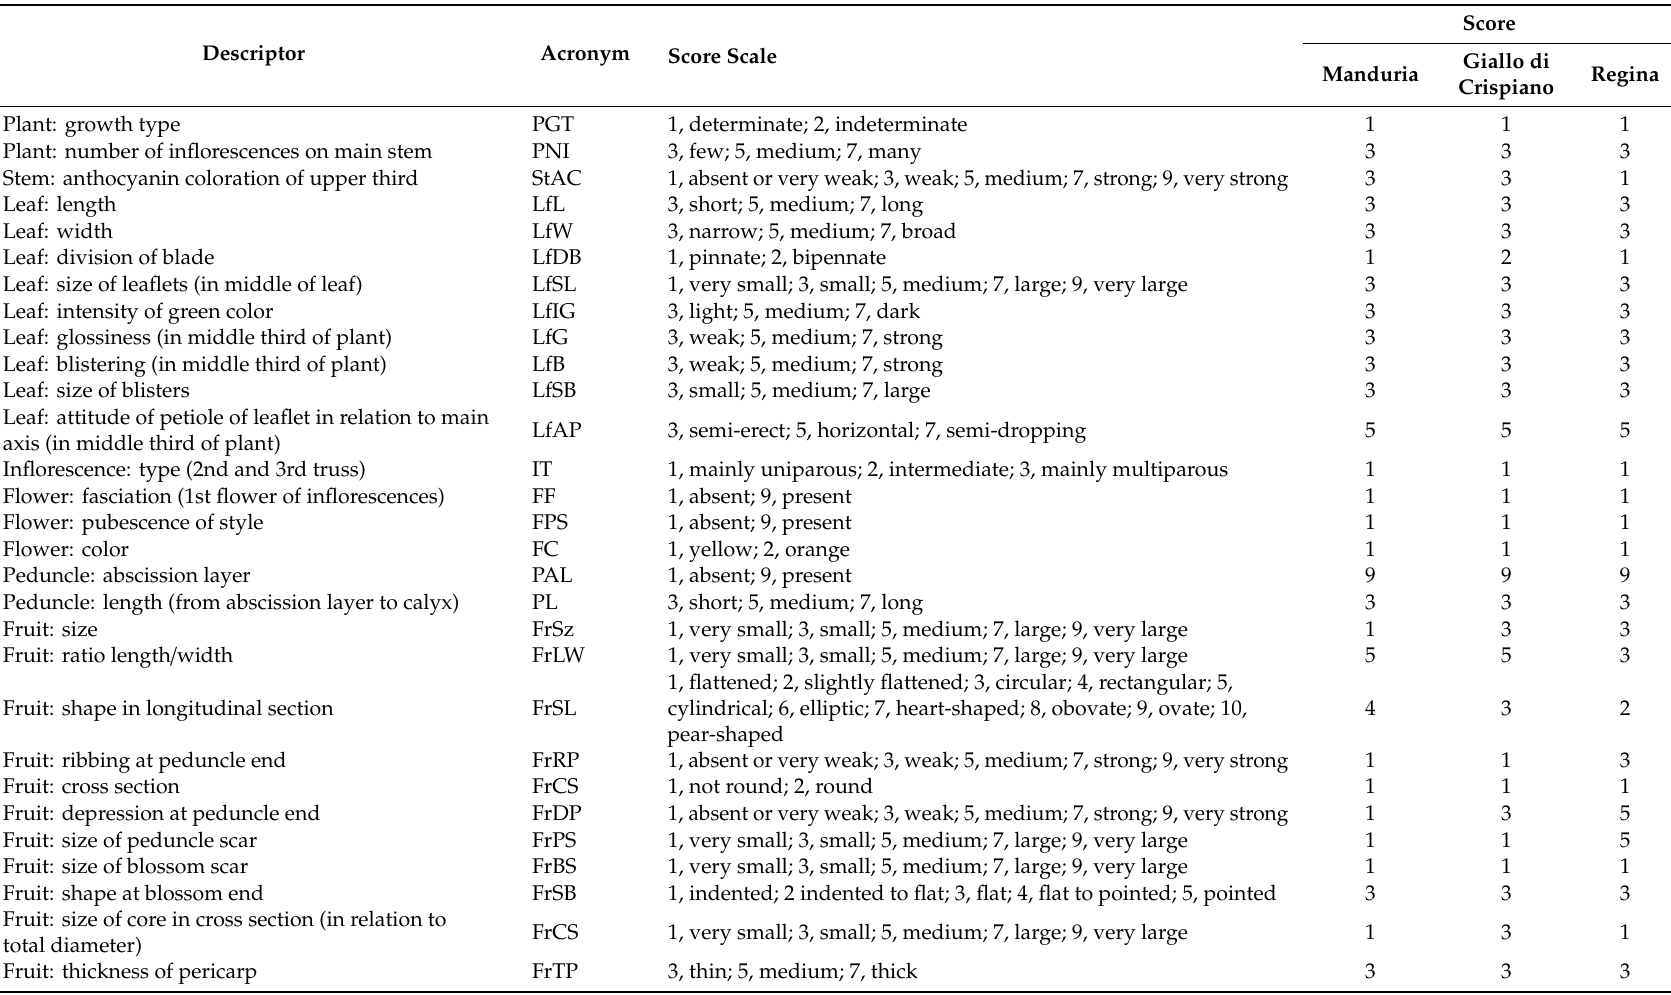
Table 1. Data of morphological traits scored in the three landraces according to the UPOV (International Union for the Protection of new Varieties of Plants) Guideline TG / 44 / 10 for the conduct of tests for Distinctness, Uniformity and Stability on tomato (UPOV Species Code: LYCOP_ESC). Descriptor Acronym Score Scale